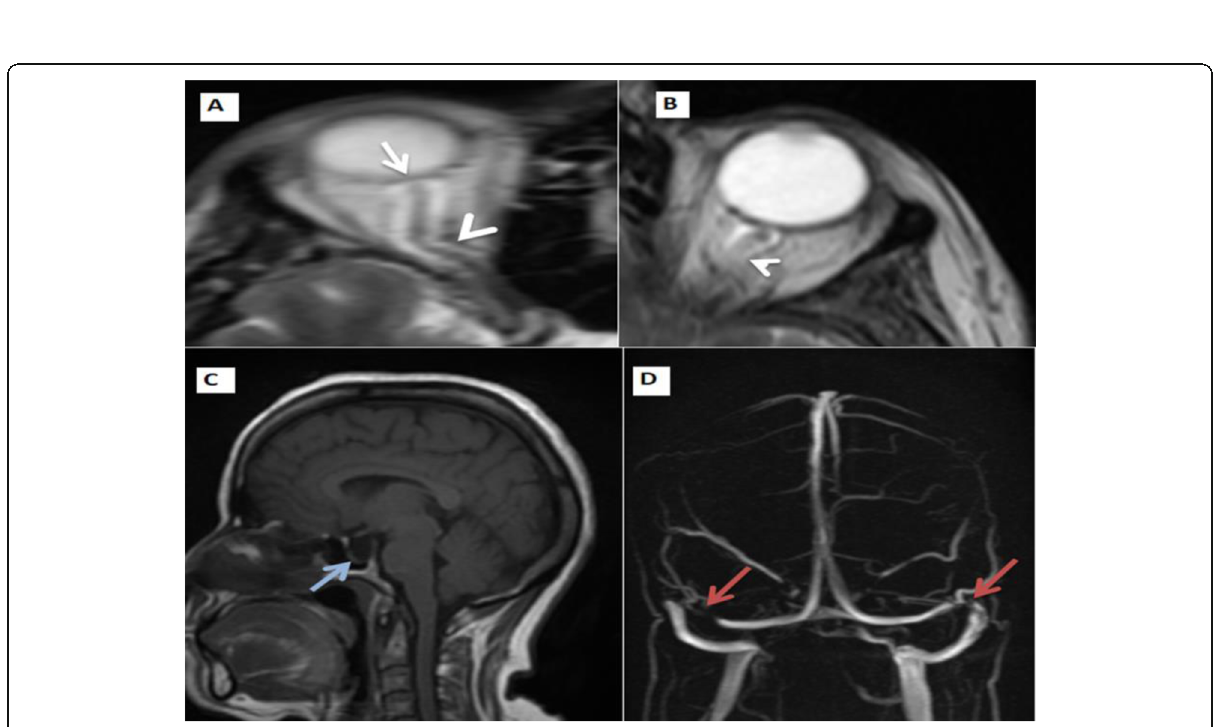
Fig. 3 a – d MRI and MRV of 28 year aged female patient diagnosed with idiopathic increase intracranial tension. a , b Axial T2 scan of both orbits shows tortuosity of right optic nerve, grade 1 distention of both optic nerve sheaths (arrowheads) with flattened right posterior globe (arrow). c A mid-sagittal T1 MRI shows enlarged sellar cavity with no detected pituitary gland inside grade 5 (empty sella) (blue arrow). d Time of flight MRV shows bilateral transverse sinus stenosis (red arrows) combined conduit score was 0 + 1 = 1